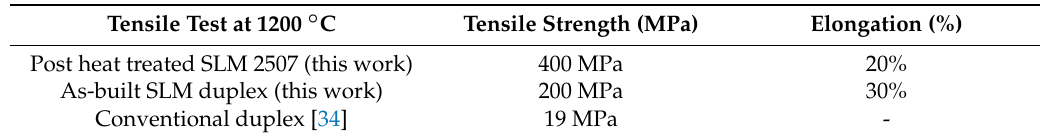
Table 2. High temperature mechanical properties of post heat treated SLM 2507 obtained at 1200 °C and comparison with conventional casted duplex steel at the same temperature.